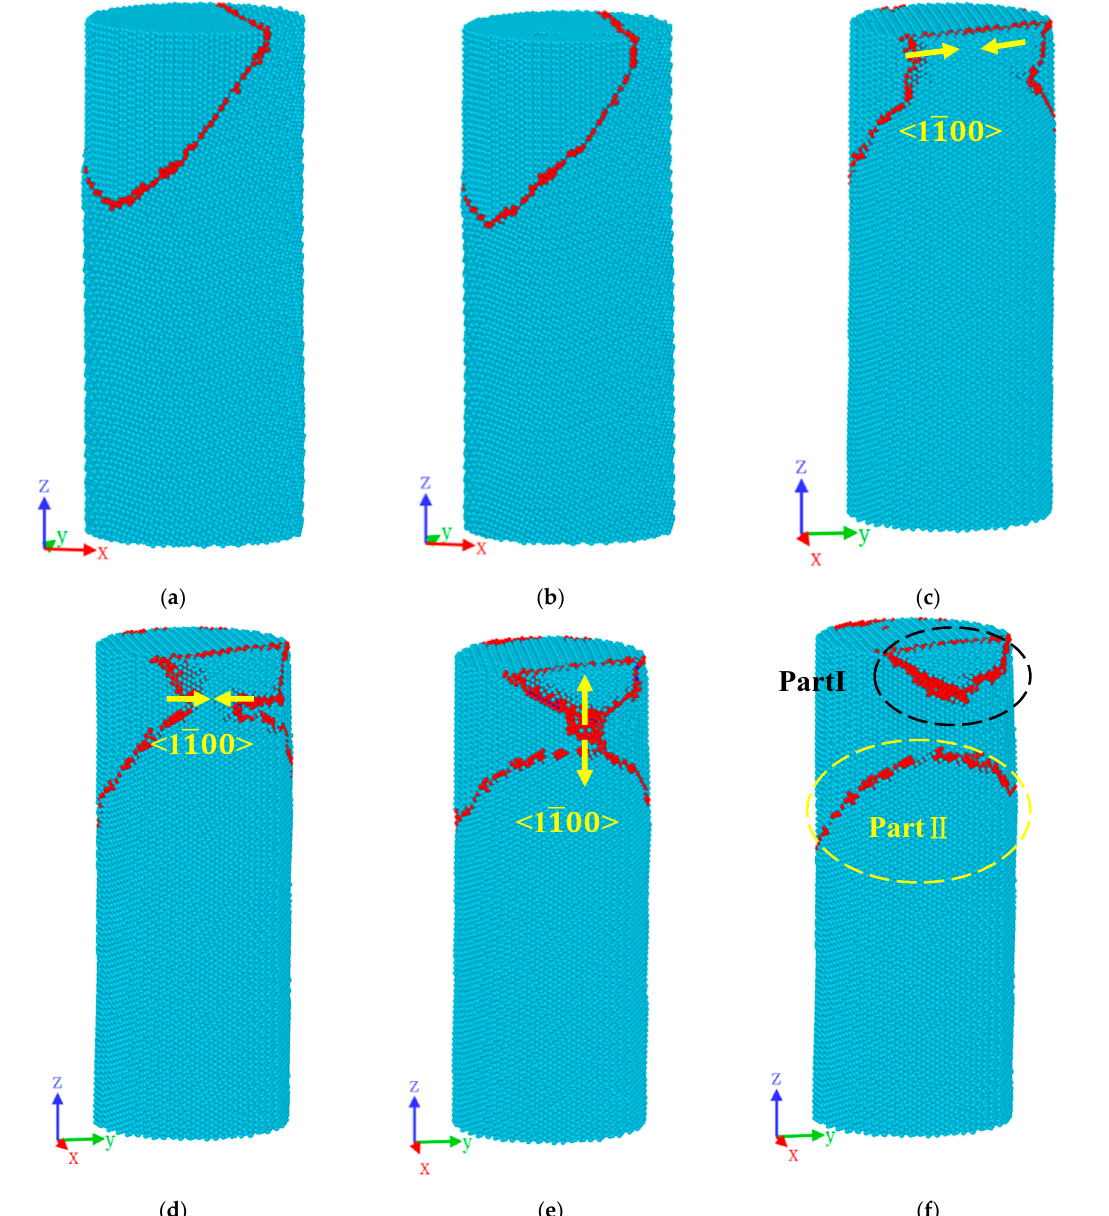
Figure 3. Initial deformation behaviors of bi-crystal Mg nanopillar at different compressive strain level: ( a ) 0.017; ( b ) 0.035; ( c ) 0.038; ( d ) 0.039; ( e ) 0.041; ( f ) 0.044. Snapshots in Figure 3 ( a–f ) are related to the tagged Points (A–F) in Figure